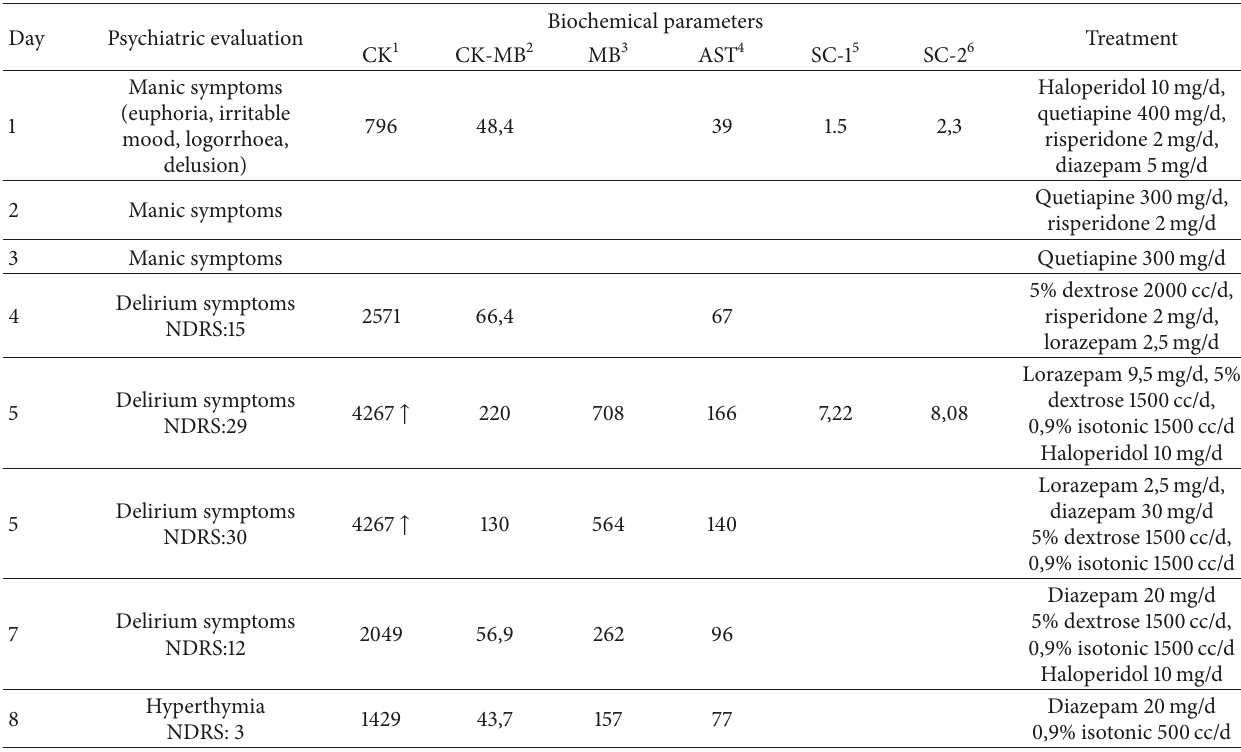
Table 2: Case 1 clinical observation and